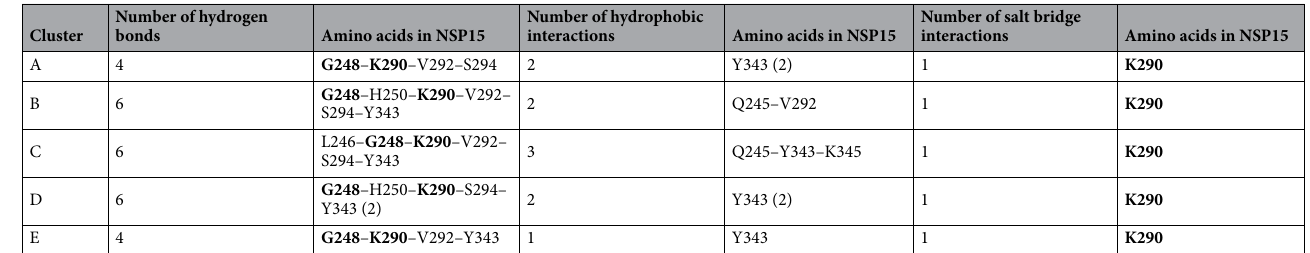
Table 1. PLIP web server analysis for NSP15-ZINC000104379474 complex. Bold amino acids indicate that they are most common in all cluster